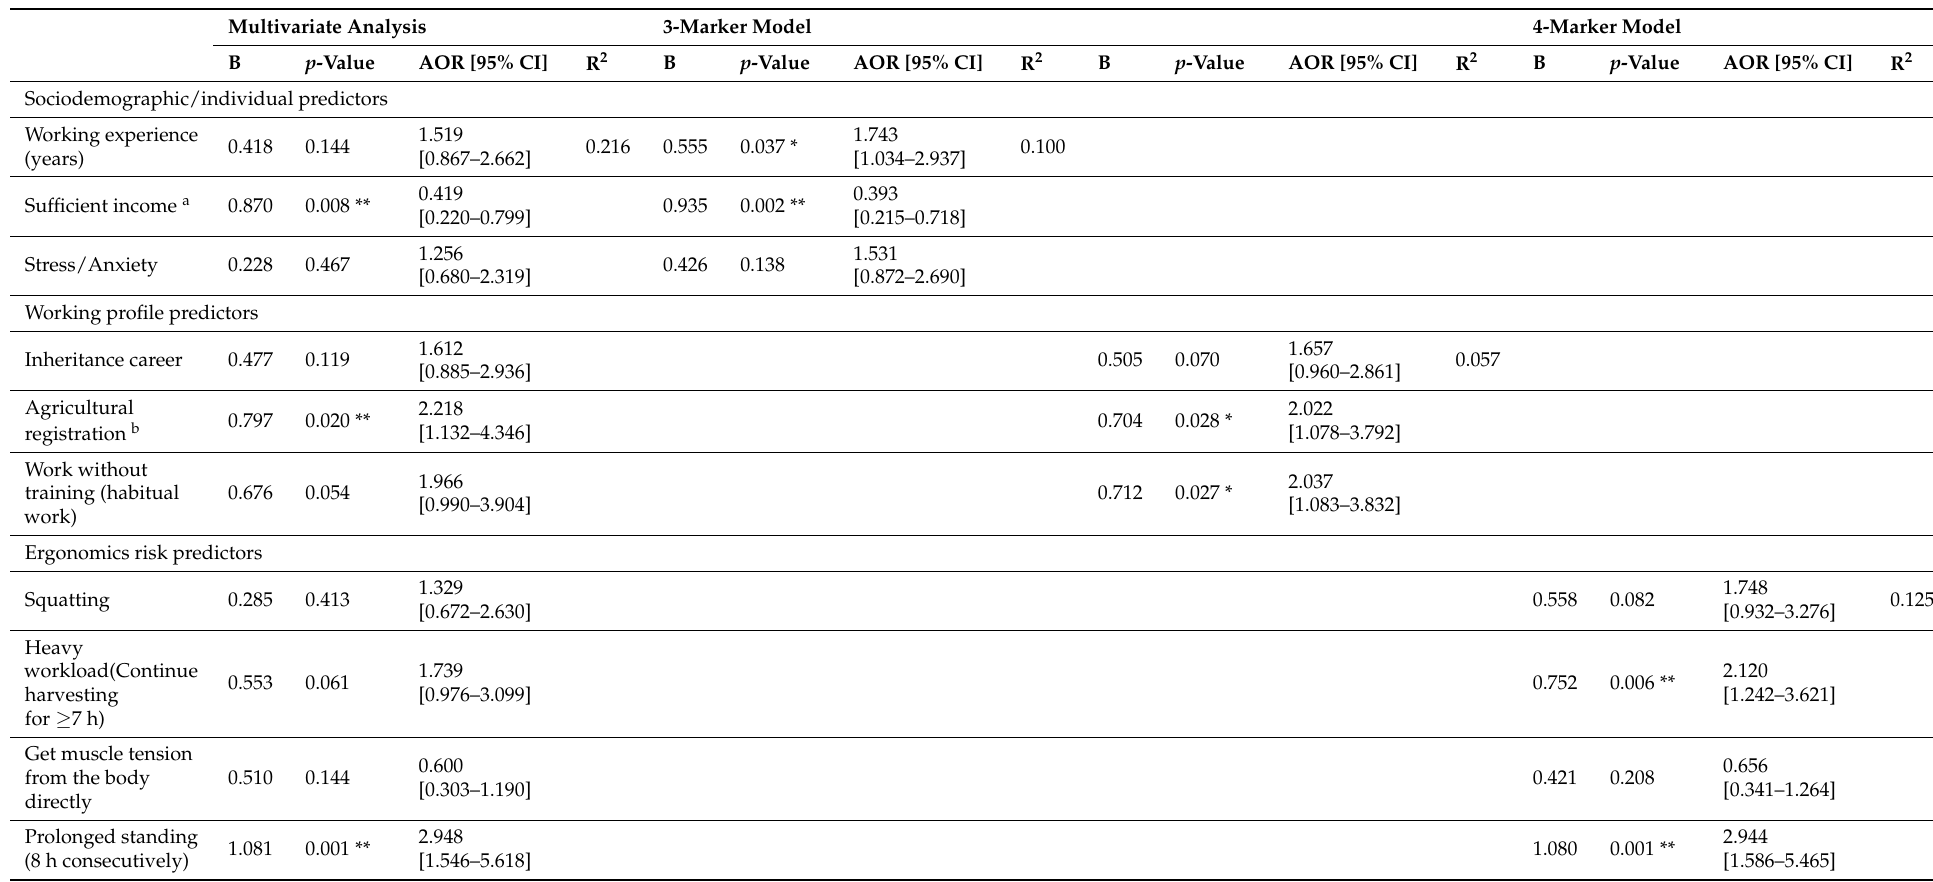
Table 4. Multivariate analyses of risk factors associated with LBP of rubber